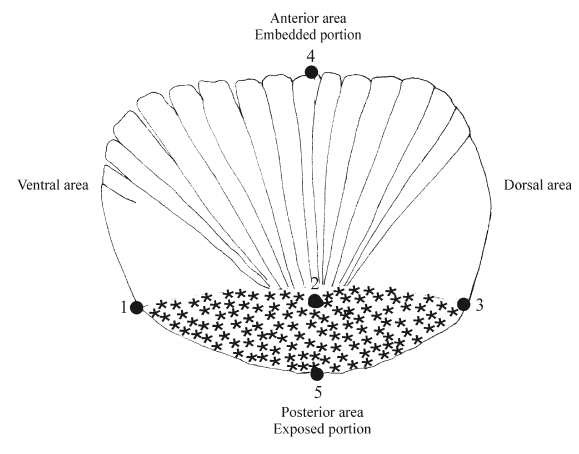
Fig . 2. – Location of landmark on scales of Lutjanid fishes used in